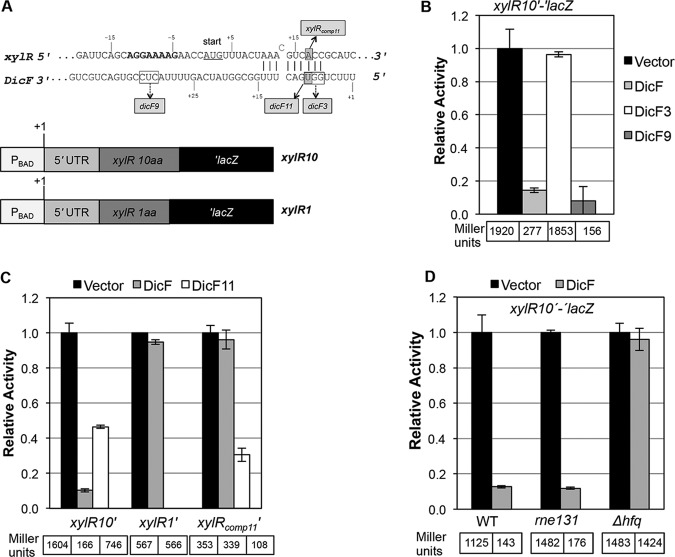
Genetic and molecular characterization of DicF-xylR mRNA interactions. (A) Base pairing predictions for xylR mRNA and DicF. The numbers for xylR are relative to the start codon (with A as +1). The numbers for DicF are relative to the 5′ end of dicF. The xylR RBS is shown in bold, and the start codon is underlined. The predicted base pairing interactions between xylR and DicF are marked by vertical lines, and mutations in dicF and xylR are indicated by boxes. All mutations were substitutions, and the boxed residues were changed to the complementary nucleotides. The cartoon depicts the xylR′-′lacZ fusion containing 10 codons or 1 codon of the xylR gene (xylR10 or xylR1, respectively). (B) The β-galactosidase activities of the xylR10′-′lacZ fusions were assayed during overexpression of DicF, DicF3, and DicF9. (C) The xylR10, xylR1, and xylRcomp11′-′lacZ fusions were assayed for β-galactosidase activity during DicF and DicF11 overproduction. (D) The levels of β-galactosidase activity of the xylR10′-′lacZ fusion in the wt strain and the rne131 and hfq mutants were assayed during overexpression of DicF. The specific activities of the fusions were normalized as described for Fig. 2.